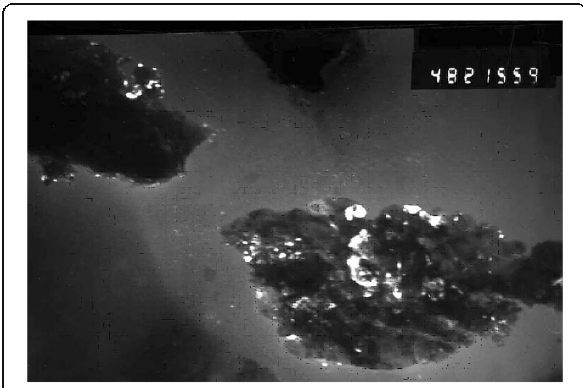
Fig. 4 Micrograph of rhodium nanoparticles (10 – 22 nm) obtained at the platinum cathode in molten mixture urea-NH 4 Cl